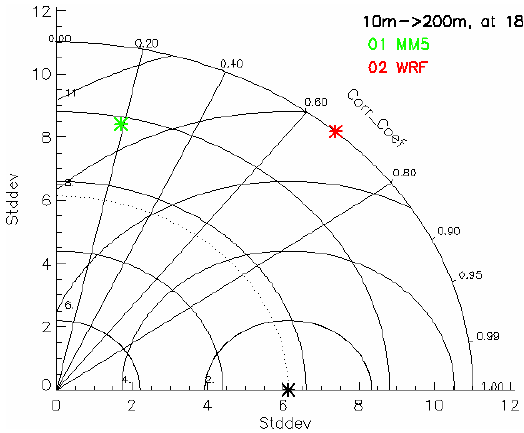
Fig. 3e. Statistics (Taylor plot, Taylor, 2001) for vertical potential temperature gradient profiles (10m–200m) by WRF, MM5 for the Linate airport, together with the observations for 18:00h for the whole